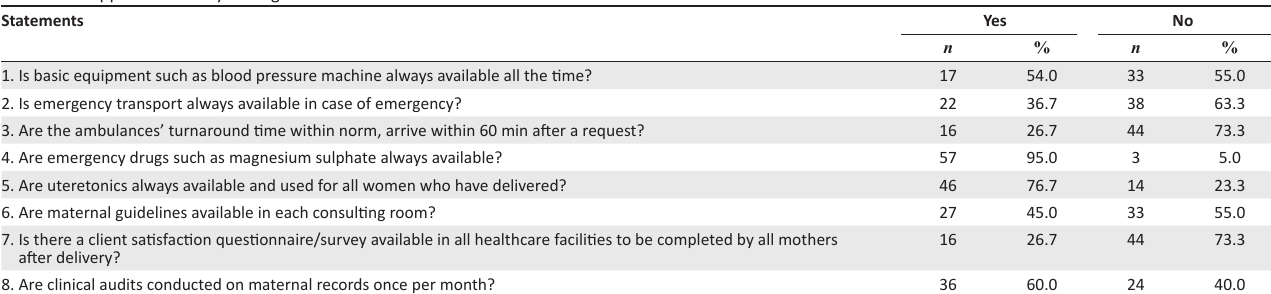
TABLE 2b: Support offered by managers related to material resources.